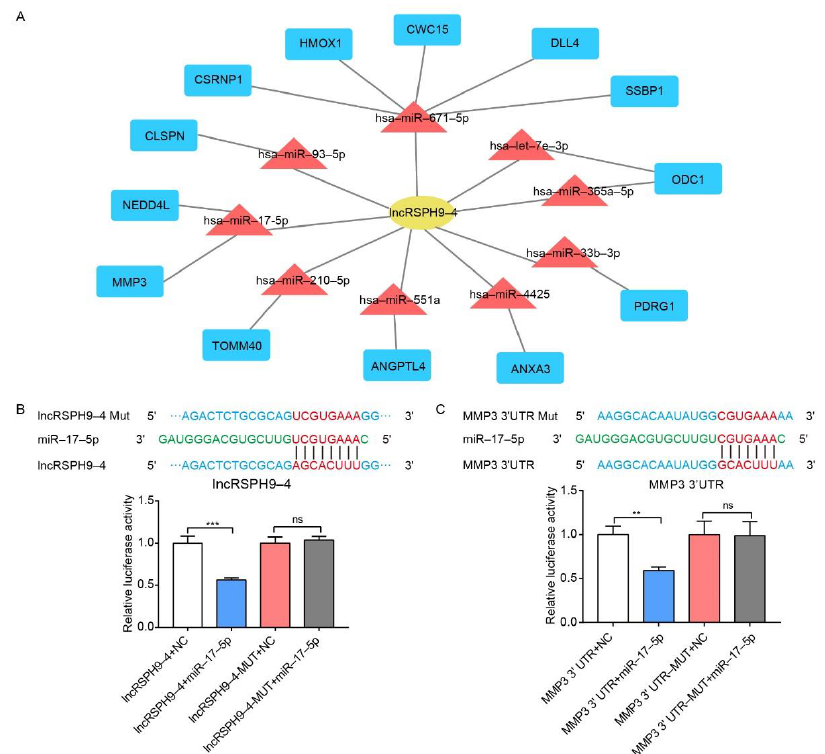
Figure 5. The competing endogenous RNA network of lncRSPH9-4 . ( A ) Regulatory network analysis of lncRSPH9-4 associated with significantly changed mRNAs and miRNAs based on ceRNA theory. ( B ) Predicted binding sites between lncRSPH9-4 and miR-17-5p . Dual-luciferase reporter assays showing that miR-17-5p significantly reduced the luciferase activity of the wild-type lncRSPH9-4 construct but not of the mutant construct. Data were presented as mean ± SD from three independent experiments. *** p < 0.001; ns, not significant. ( C ) Predicted binding sites between the MMP3 3 ′ UTR region and miR-17-5p . Dual-luciferase reporter assays showing that miR-17-5p significantly reduced the luciferase activity of the wild-type MMP3 3 ′ UTR construct but not of its mutant construct. Data were presented as mean ± SD from three independent experiments. ** p < 0.01; ns, not significant.